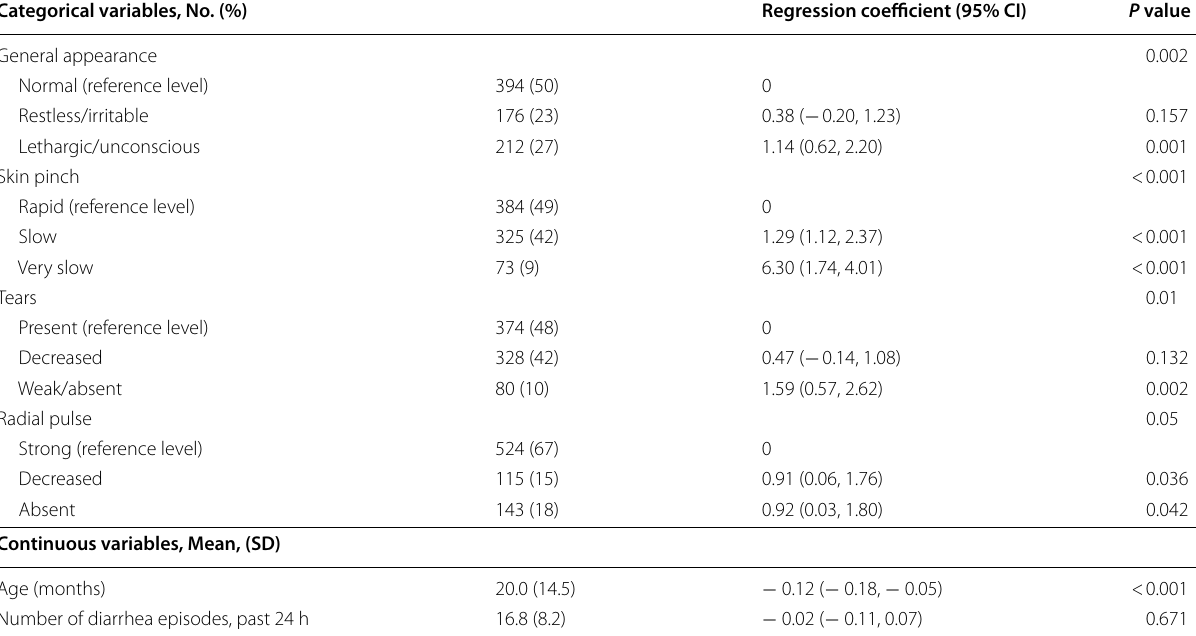
Table 3 Predictors and regression coefficients in the DHAKA model Categorical variables, No. (%)